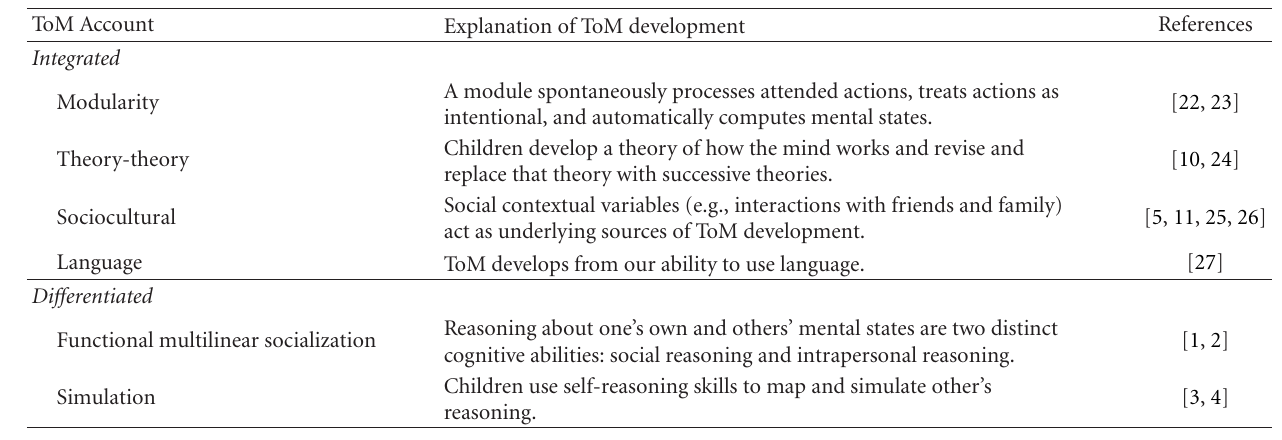
Table 1: Predominant accounts of Theory of